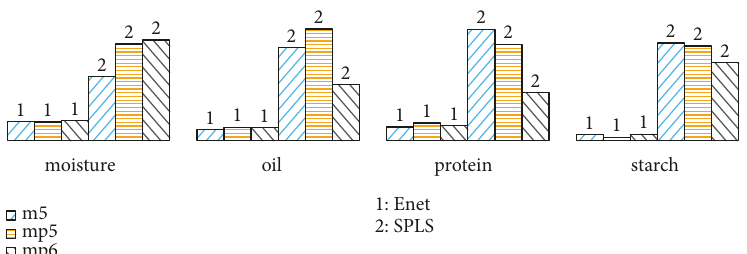
Figure 5: The comparison of Enet and SPLS on corn data set. Three measures “trainMSE”, “testMSE”, and “Num of selected” are scaled to unit one. The results of Enet and SPLS are marked by the numbers “1” and “2”, respectively. The results of three predictor matrices of “m5spec”, “mp5spec”, and “mp6spec” combination of four responses are, respectively, shown by deepskyblue, orange, and grey bars.